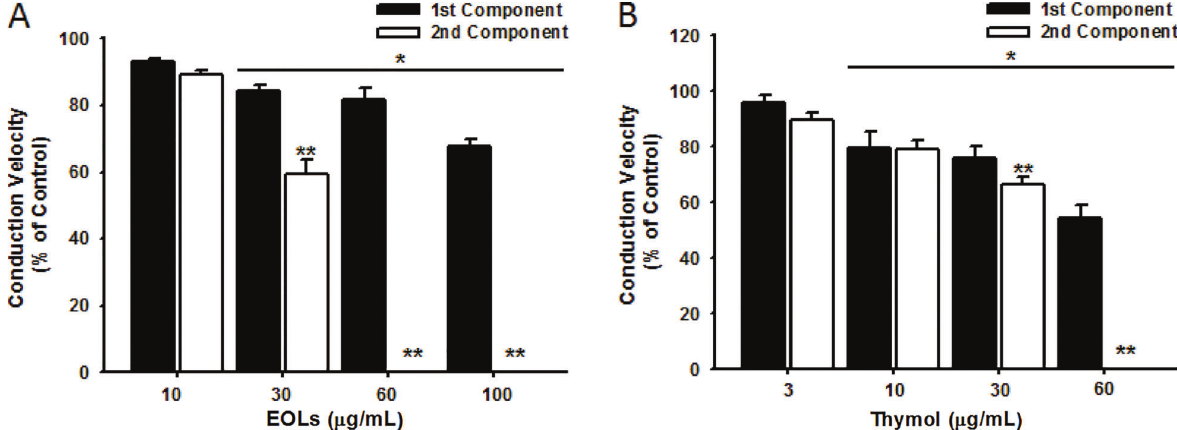
Figure 3. Effect of essential oil of L. sidoides (EOL) and thymol on conduction velocity of compound action potential component. Data are reported as means ± SD. *P o 0.05, **P o 0.01, compared to control (ANOVA, followed by Bonferroni ’ s post hoc